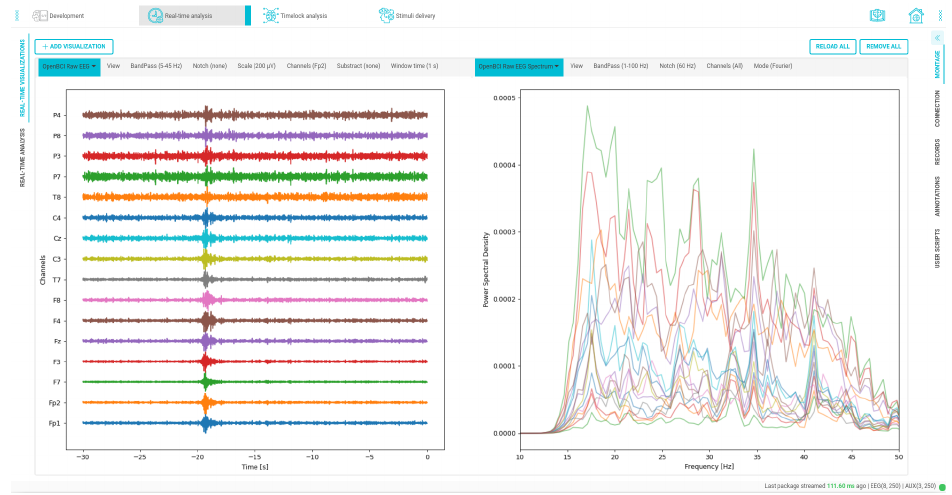
Figure 17. Time and frequency custom data visualizations. On the left side, the signal is filtered from 5 to 45 Hz, and on the right side, the spectrum of the channels is visualized within a bandwidth ranging from 1 to 100 Hz.